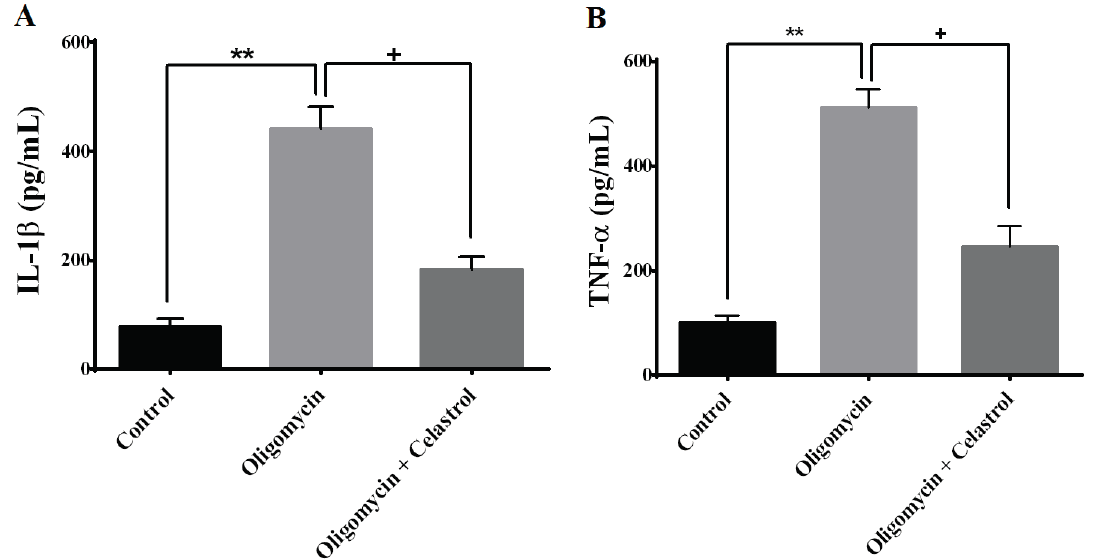
Figure 6. Effects of celastrol treatment on differentiated 3T3-L1 adipocytes treated with oligomycin. The measurement of pro-inflammatory cytokine ( A ) interleukin-1 β (IL-1 β ) and ( B ) tumor necrosis factor- α (TNF- α ) was analyzed using a commercially available ELISA kit. Results were expressed as means ± SEM ( n = 8). ** p < 0.01 vs . untreated control; + p < 0.05 vs . oligomycin-treated